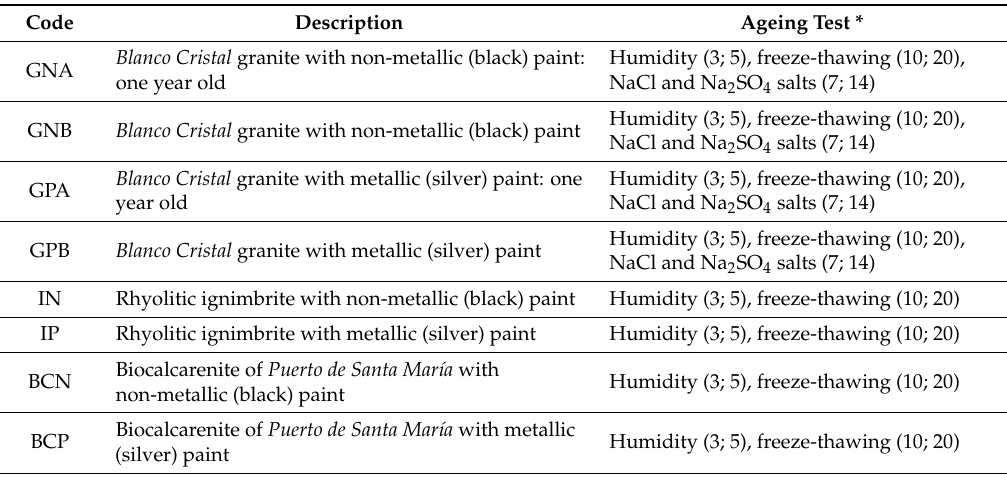
Table 1. Samples used for weathering tests: code, description and type of ageing